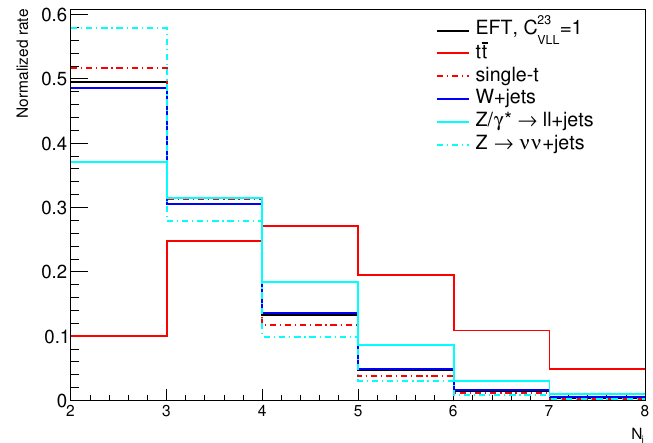
Figure 3 . The N j distribution of the signal with C 23 to include at least two jets, N j ≥ 2 , and less than two b -jets, N b < 2 , and satisfy p T ( τ ) > 50 GeV (for the leading jet if no τ -jet is found) and p miss